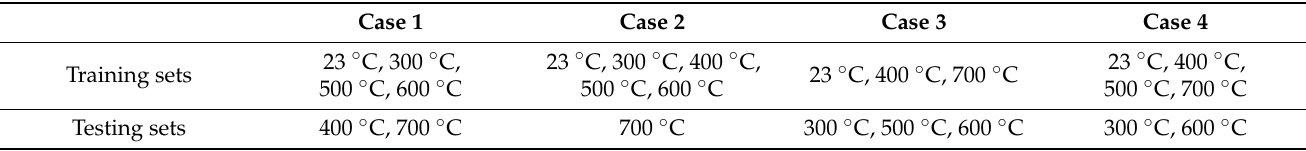
Table 1. Four different cases of training sets and testing sets of fatigue strength data.